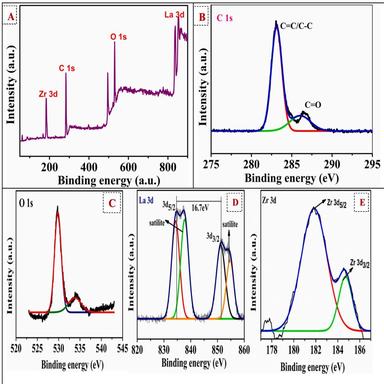
XPS spectra of GQDs@La3+@ZrO2 nanocomposites; (A) XPS survey spectrum, (B) binding energy spectrum for C1s, (C) binding energy spectrum for O1s, (D) binding energy spectrum for La3d and (E) binding energy spectrum for Zr3d.